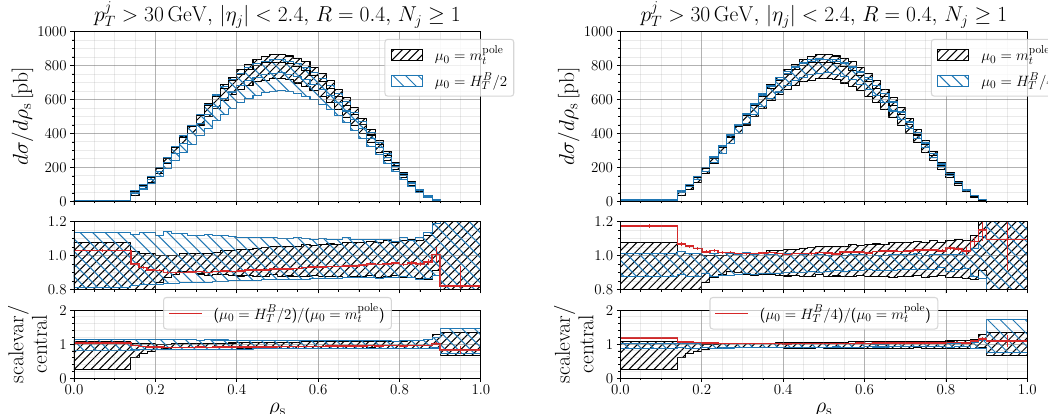
Figure 6 . NLO differential cross section as a function of ρ s for the pp → t ¯ tj + X process at √ S = 13 TeV calculated using the static central scale µ 0 = m t (black) and the dynamical central scale µ 0 = H B / 2 (blue) (left panel) or the dynamical central scale µ 0 = H B T Thereby the envelopes of the seven-point scale variation and the central scale predictions are shown. In the two lower insets the ratios of the scale variation bands with the corresponding central scale predictions are shown with two different ranges on the y -axis, respectively. Additionally, the ratio of the central prediction obtained with the dynamical scale with the one obtained with µ 0 = m t is shown with the red